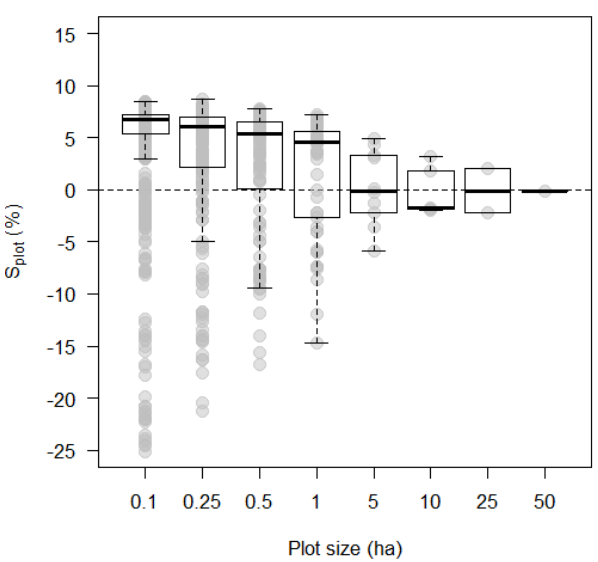
Figure B2. Plot-level relative error ( S plot , in %) as a function of plot size (in ha) in the Korup permanent plot. Individual plot values are represented by grey dots. 14